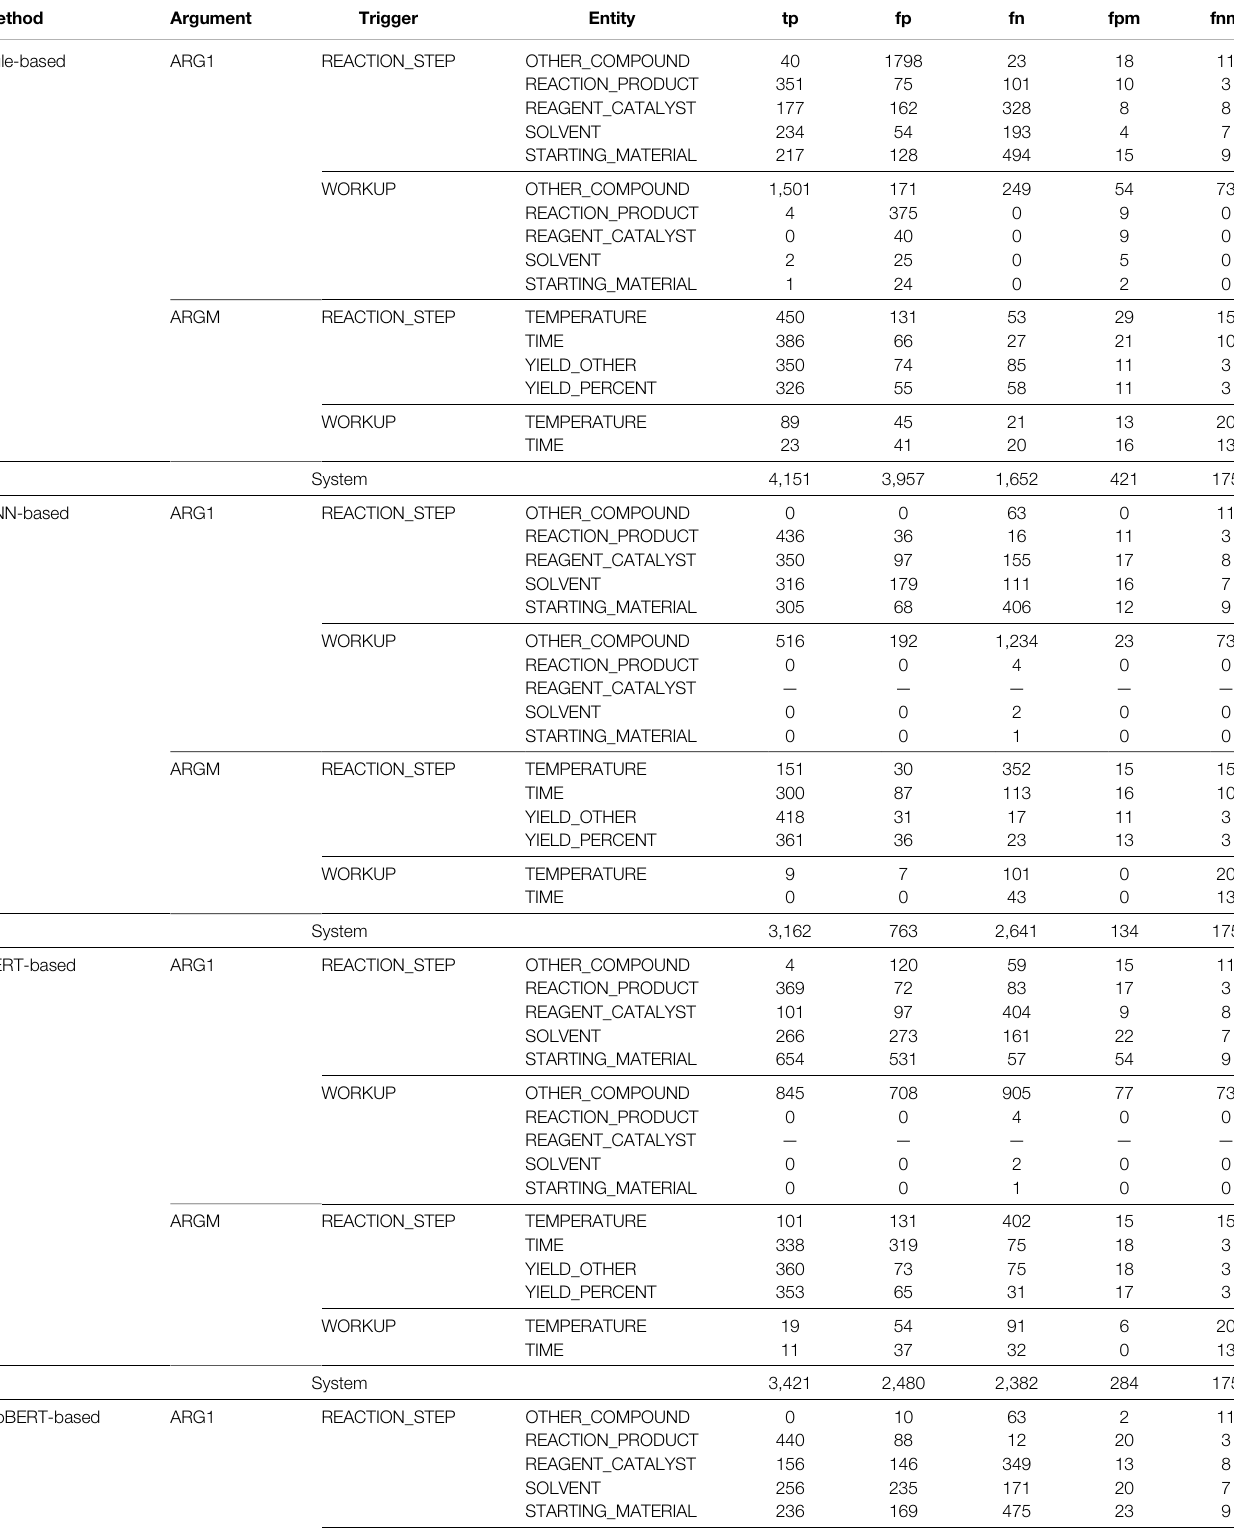
TABLE 6 | Error analysis for the event extraction (EE) system where trigger words are trained with ChemPatent embeddings. Method Rule-based